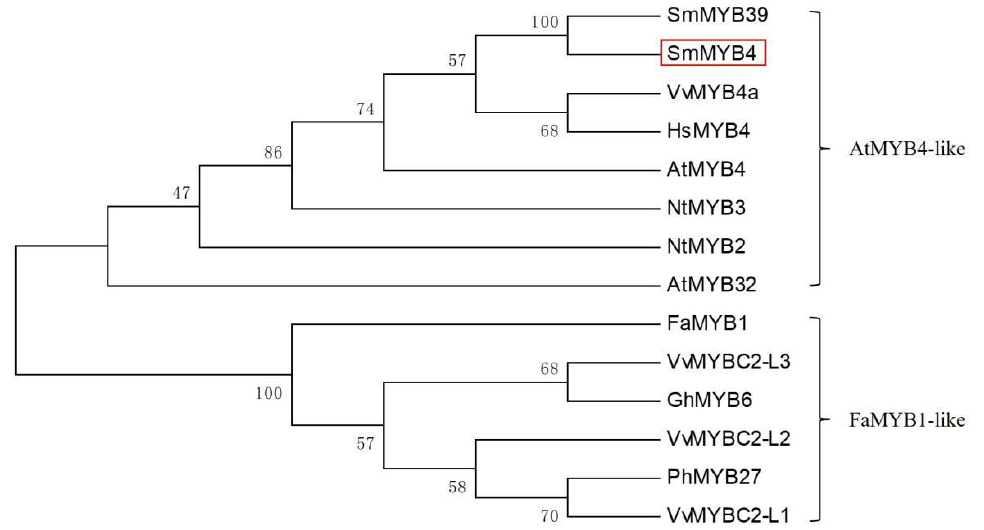
Figure 1. Phylogenetic analysis of the MYB repressors. SmMYB4 is shown by the red rectangle. S. miltiorrhiza SmMYB39 (AGS48990.1), SmMYB4 (ADG46002.1), Arabidopsis thaliana AtMYB4 (NP_195574.1), AtMYB32 (NP_195225.1), Fragaria ananassa FaMYB1 (AAK84064.1), Narcissus tazetta NtMYB3 (AGO33166.1), NtMYB2 (ATO58377.1), Hibiscus syriacus HsMYB4 (KAE8690675.1), Petunia hybrid PhMYB27 (AHX24372.1), Vitis vinifera VvMYB4a (NP_001268129.1), VvMYBC2-L1 (ABW34393), VvMYBC2-L2 (ACX50288), VvMYBC2-L3 (AIP98385.1), Gossypium hirsutum GhMYB6 (AAN28286.1).